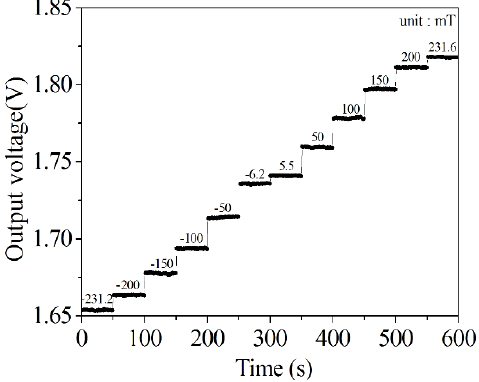
Figure 12. Output voltage of the magnetic sensor under different magnetic fields.